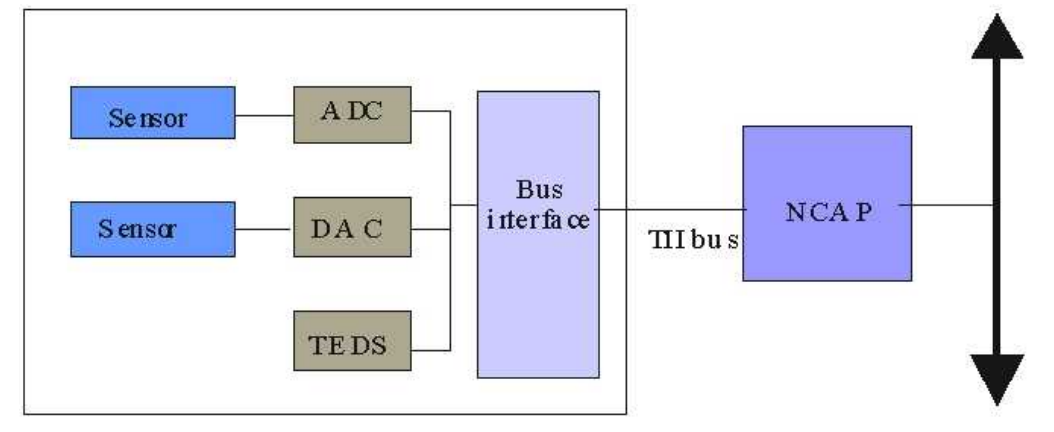
Figure 3. Physical representation of IEEE